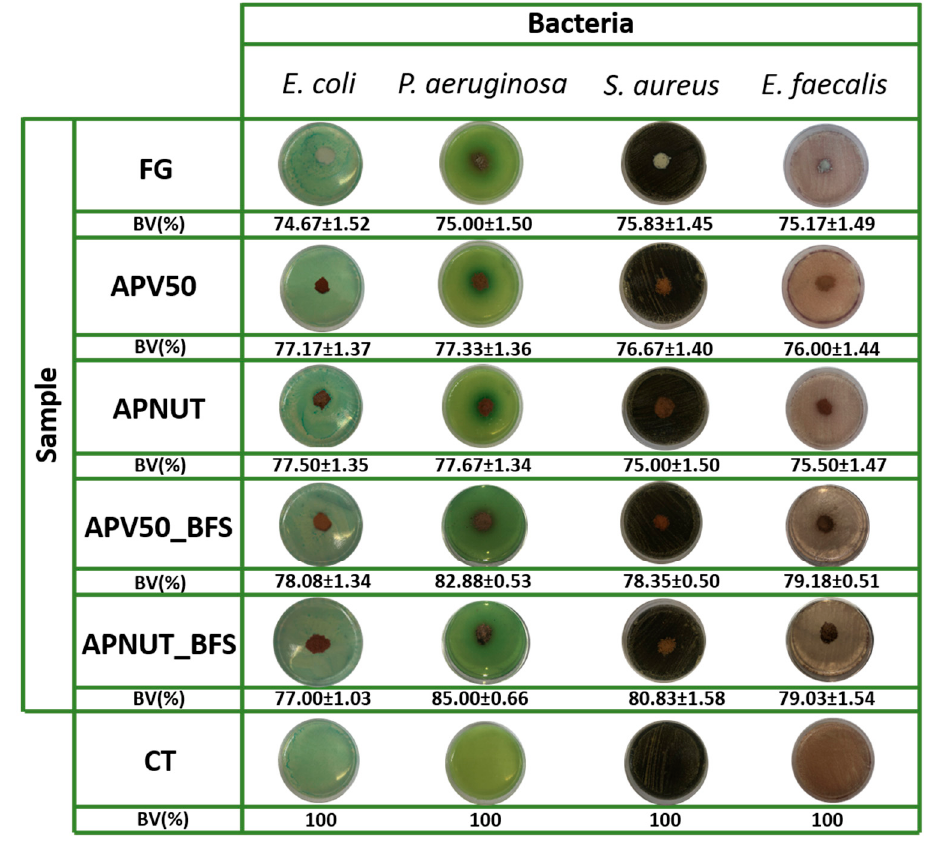
Figure 5. Bacterial viability (BV (%)) data and antibacterial assay figures. CT = control.